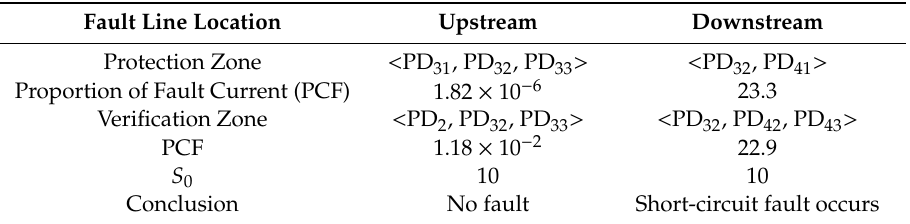
Table 5. The LCDP calculation result of PD 32 .